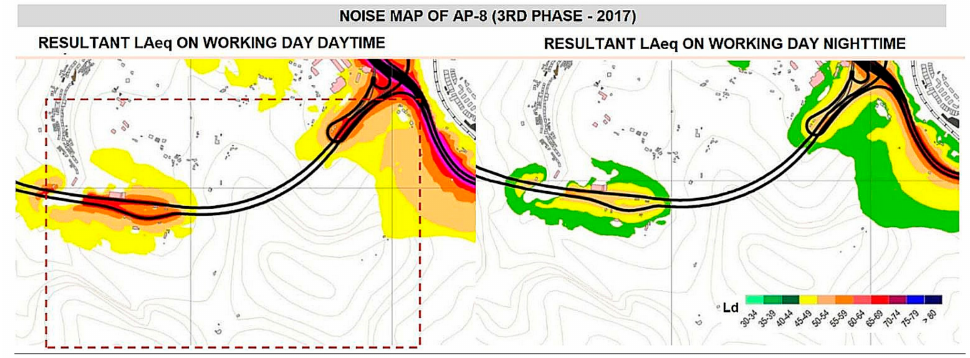
Figure 10. Noise map assessment before the start of the